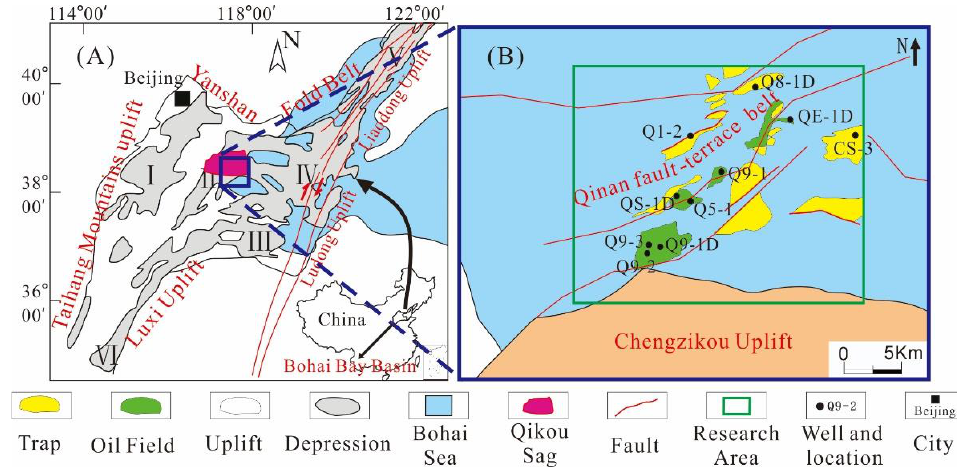
Figure 1. ( A ) A map showing the location of the Qikou Sag and the subunits of the Bohai Bay Basin. The depressions in the Bohai Bay Basin include the Jizhong depression (I), Huanghua depression (II), Jiyang depression (III), Bozhong depression (IV), and Liaohe depression (V) [34,35]. ( B ) A map showing the main well location distribution of Qikou Sag.